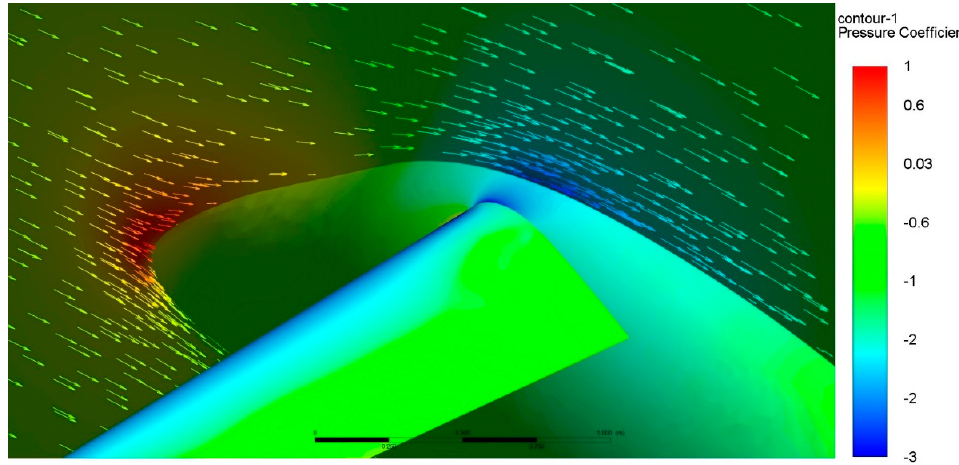
Figure 10. Pressure and velocity in a section plane near the fore–wing–body junction area showing the fuselage lift contribution.